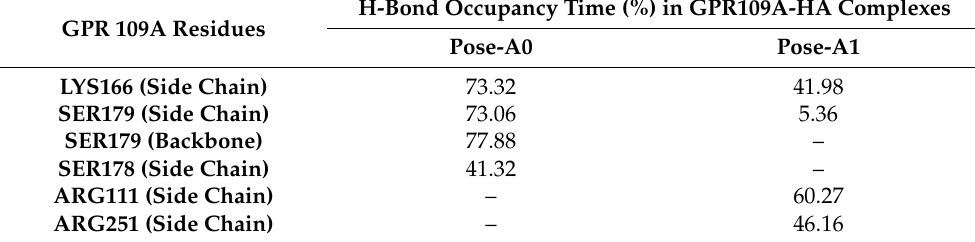
Table 1. Hydrogen bond (H-bond) occupancy of GPR109A–HA complex. Hydrogen bonds are measured with a cut-off distance of 3.5 Å and occupancy times > 5% are displayed in the